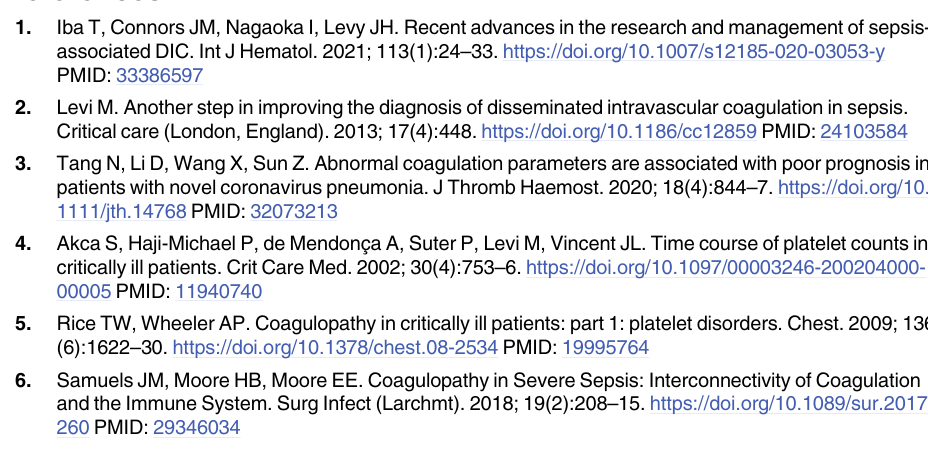
Depicted are representative results of frozen sections from 8- to 10-week-old C57Bl/6 organ Alexa 488. The sections show distribution of platelets in lung tissue: untreated mice (left fig- ure) and CASP operated (right figure) (scale bar in μ